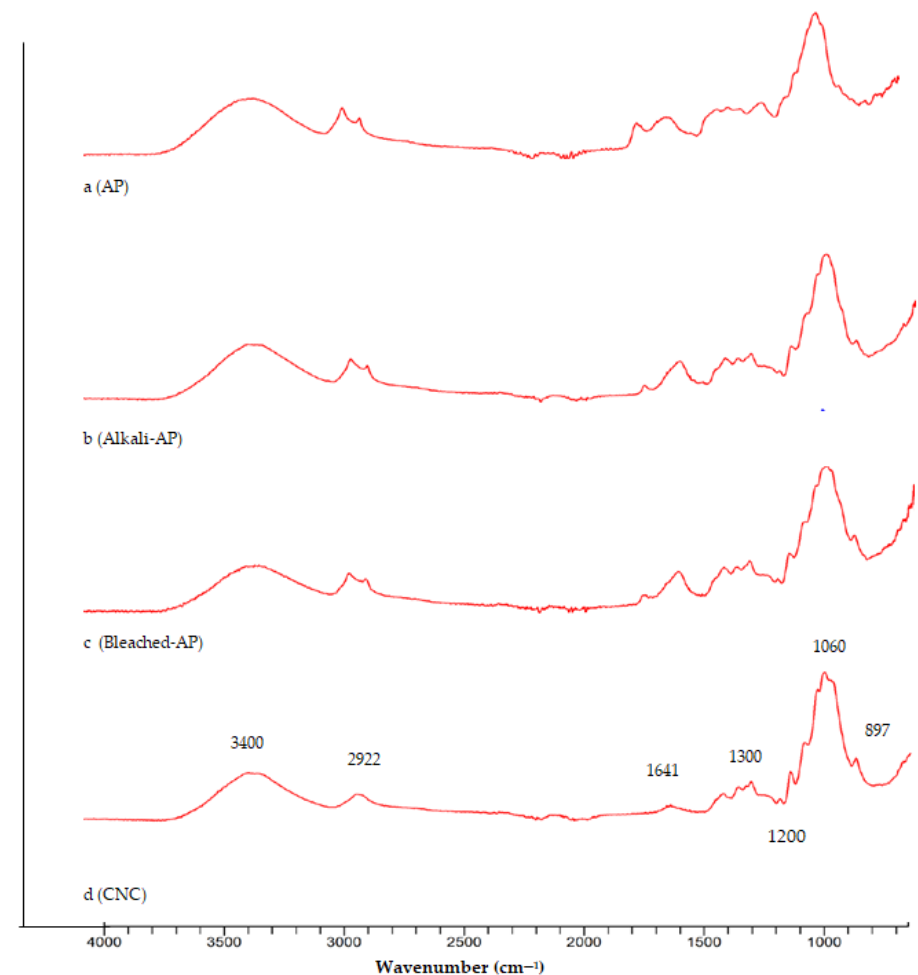
Figure 3. FTIR spectra of ( a ) AP, ( b ) alkali AP, ( c ) bleached AP, ( d ) CNC.